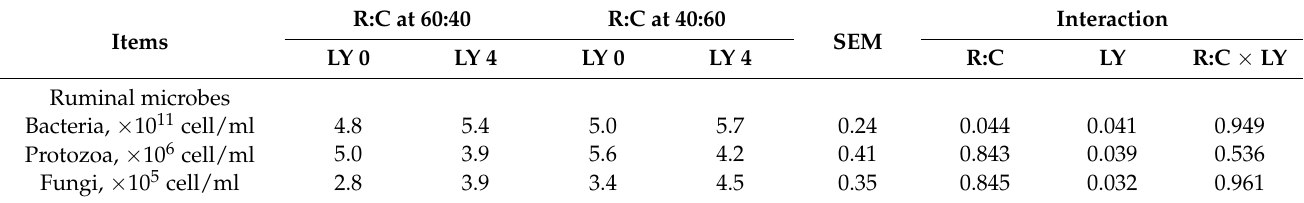
Table 4. Effect of concentrate level and live yeast supplementation on microbial population in Thai native beef